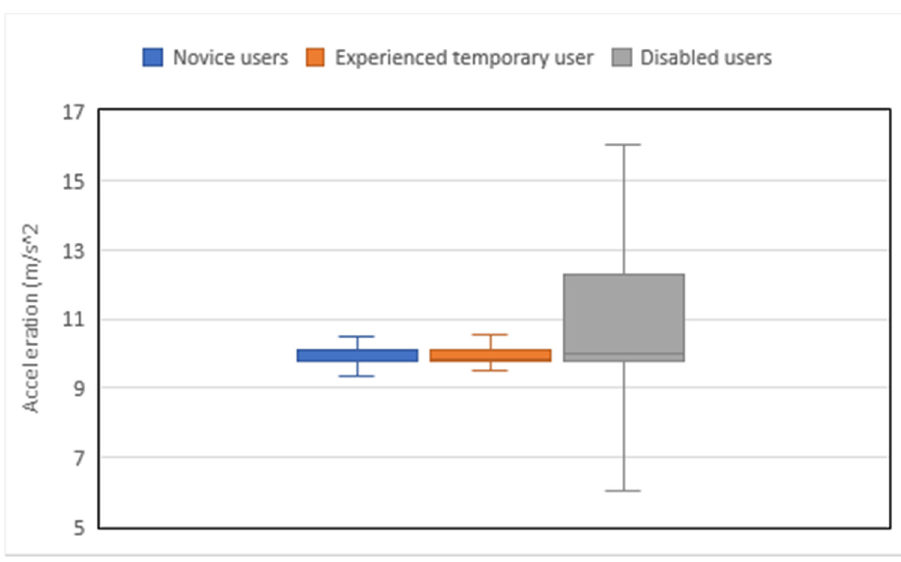
Figure 3 . Typical user in each group. Figure 3. Typical user in each